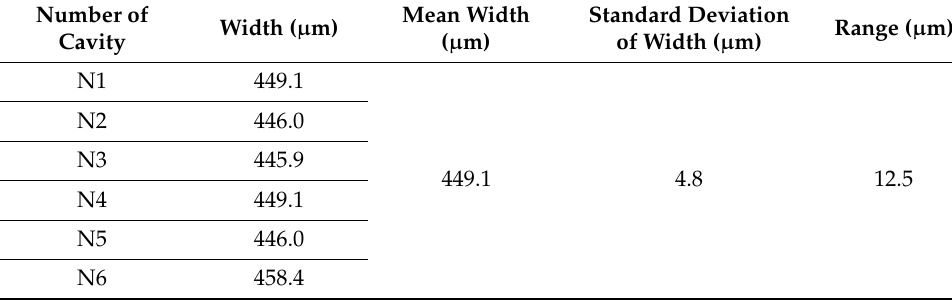
Table 5. Dimensions of machined cavities obtained in tests of repeatability